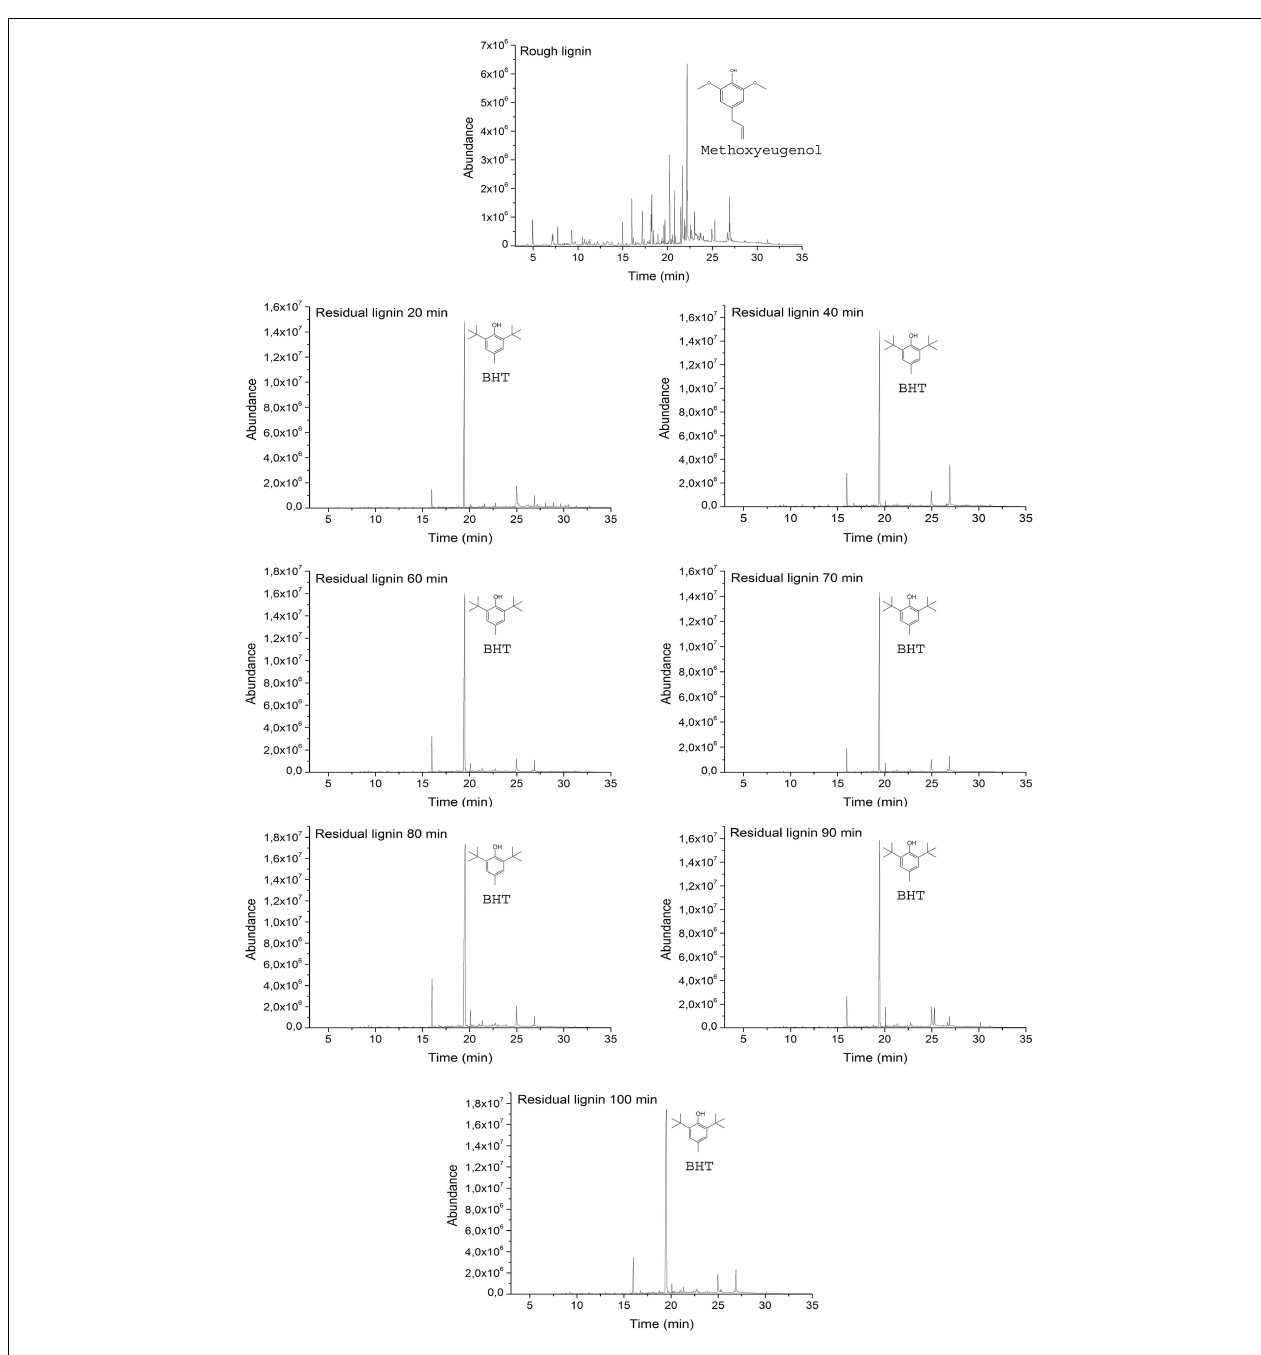
FIGURE 3 | Chromatograms of raw and residual lignins pyrolysis